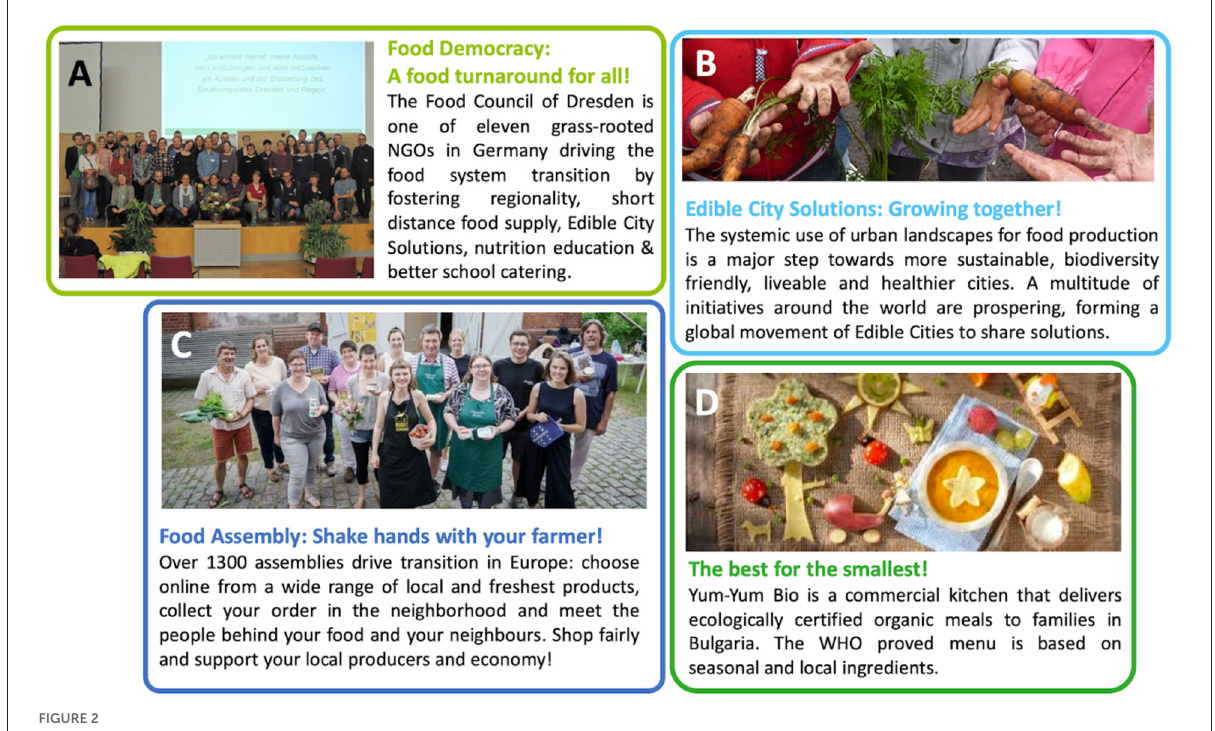
FIGURE2 Transformation of urban food system driven by the local communities. The examples reflect the four main priorities of the Food 2030 (European Commission et al., 2020) to develop future proof food systems: (A) To promote social innovation and empowerment of communities; (B) to develop climate- smart and environmentally sustainable food systems by using ecological design; (C) to enhance circularity and resource efficient food systems; and (D) to provide nutrition for sustainable and healthy diets. Sources: ernaehrungsrat-dresden.de (A) ; edicitnet.com (B) ; thefoodassembly.com (C) and biodetskakuhnia.com (D)